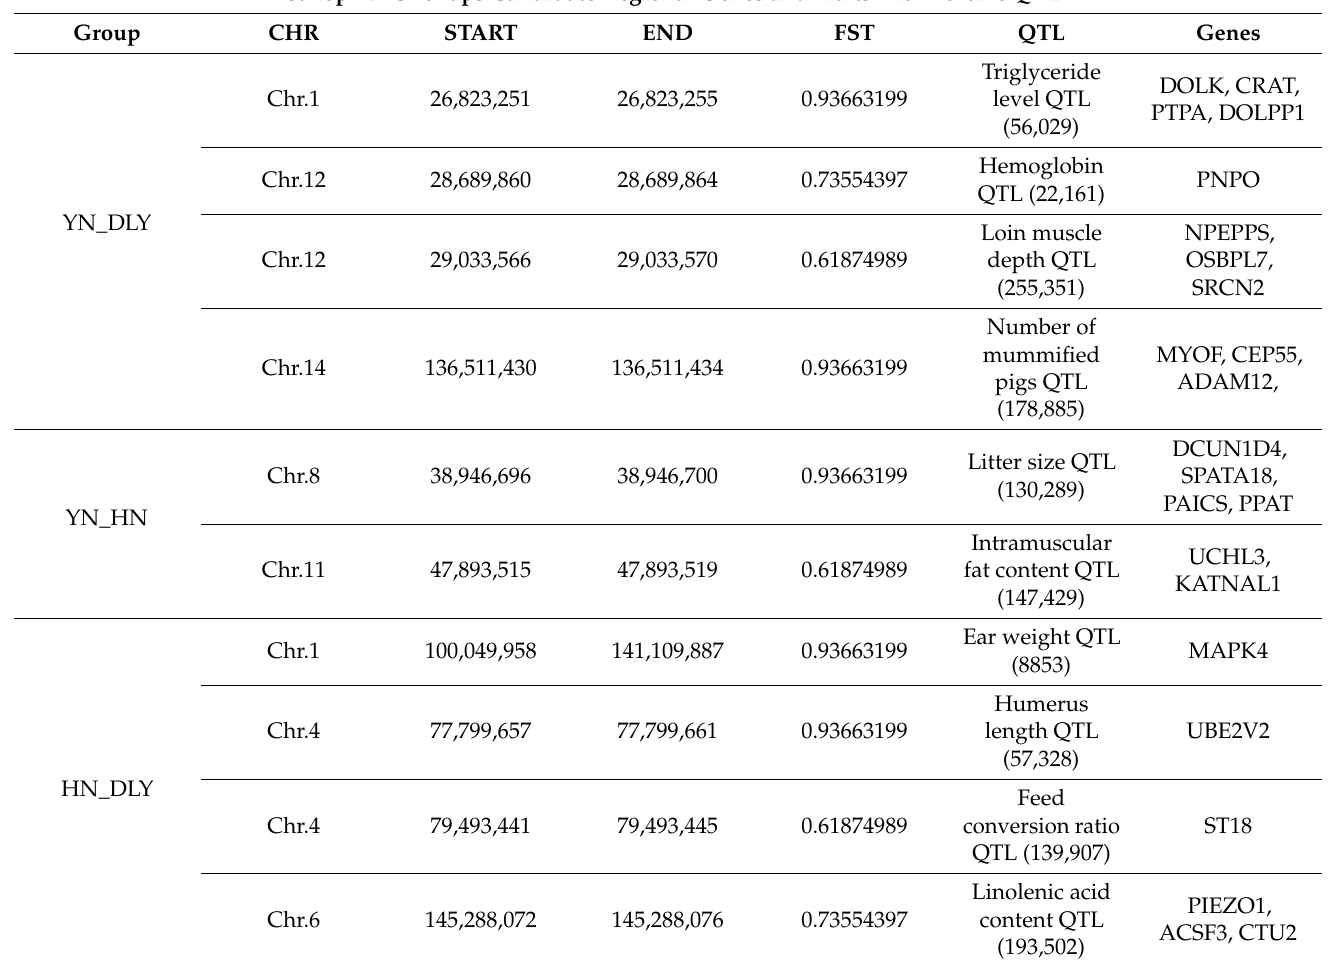
Table 1. Genomic regions identified as signatures of selection in three breeds overlapped with QTL